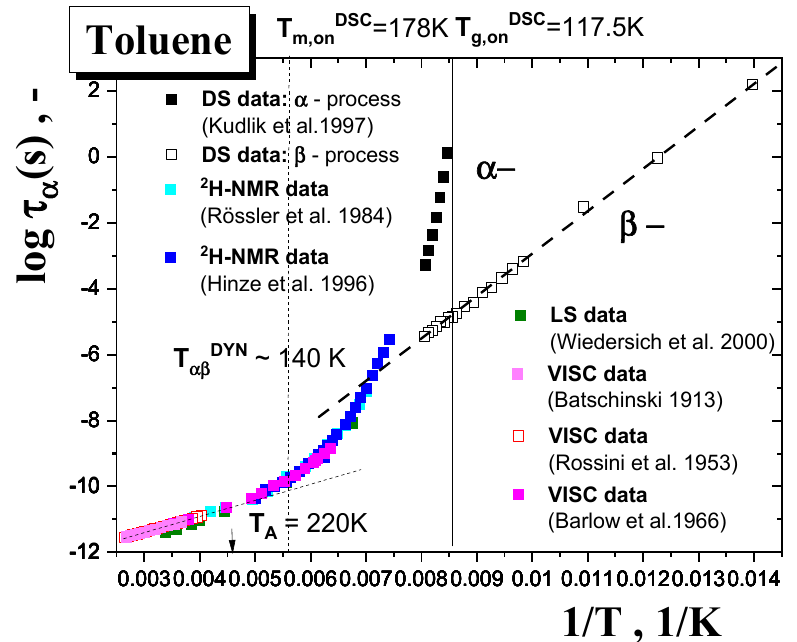
Figure 10. Relaxation map of the primary α − and secondary β − processes in amorphous TOL from DS [17], NMR [15], LS [18] and VISC [37–39] data.